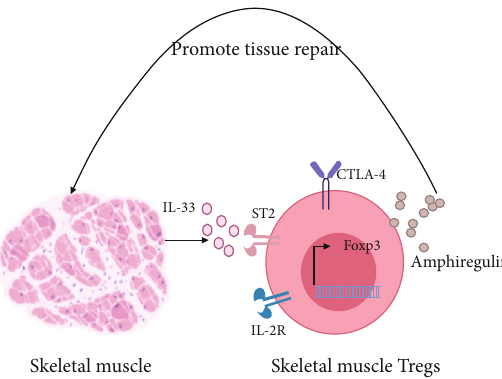
Figure 3: Skeletal muscle Treg phenotype and function. Skeletal muscle Tregs also express the conventional marker of Foxp3, CTLA-4, and IL-2R. This Treg responds to IL-33 produced after muscle injury and produces a lot of amphiregulin for subsequent